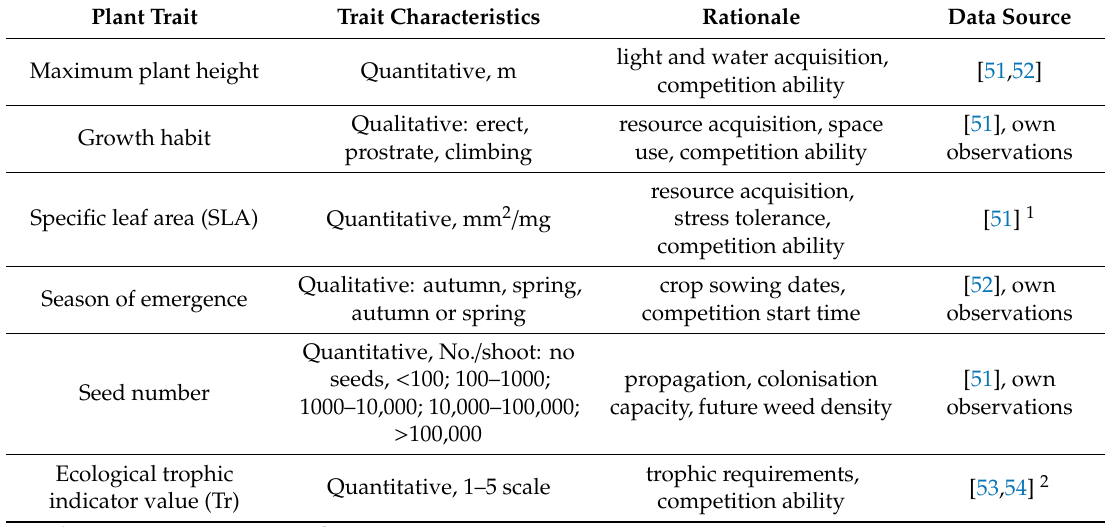
Table 4. Weed functional traits used to calculate functional diversity index ( Q